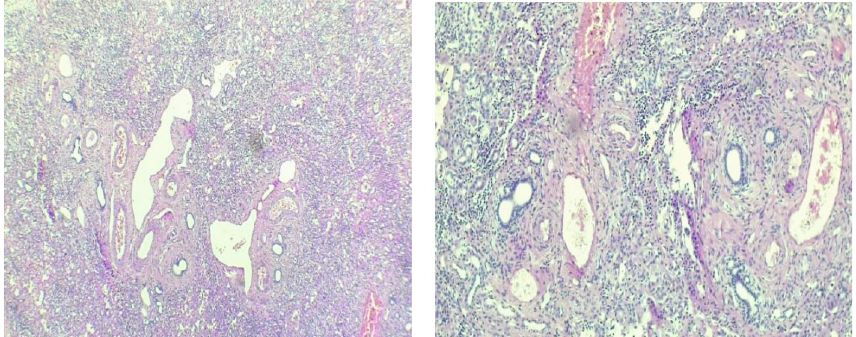
Figure 2: Interlobular bile ducts are preserved. Foci of hepatocyte con fl uent necrosis are